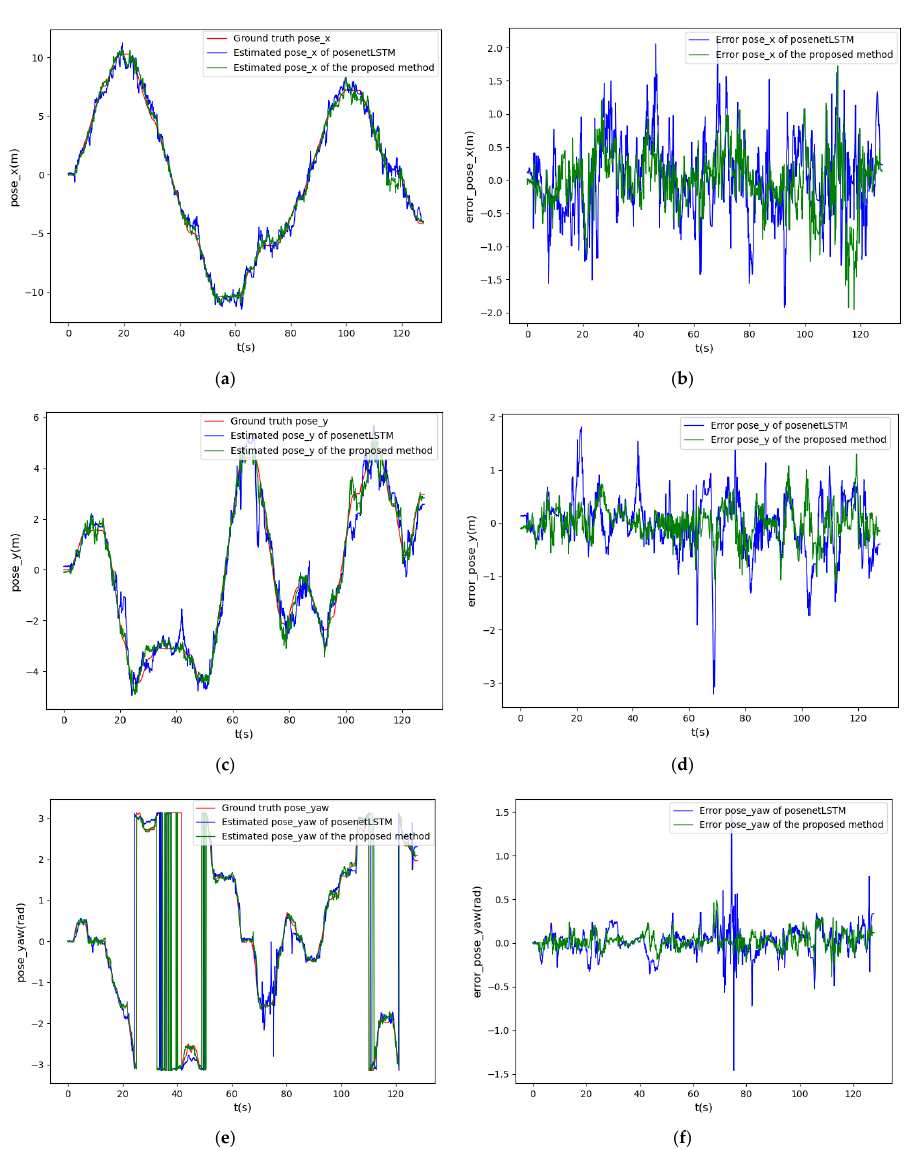
Figure 7. Visual pose tracking results based on neural network. ( a , c , e ) The comparison of pose estimation results in the x , y , and yaw directions, respectively; ( b , d , f ) The comparison of pose estimation errors in the x , y , and yaw directions, respectively.